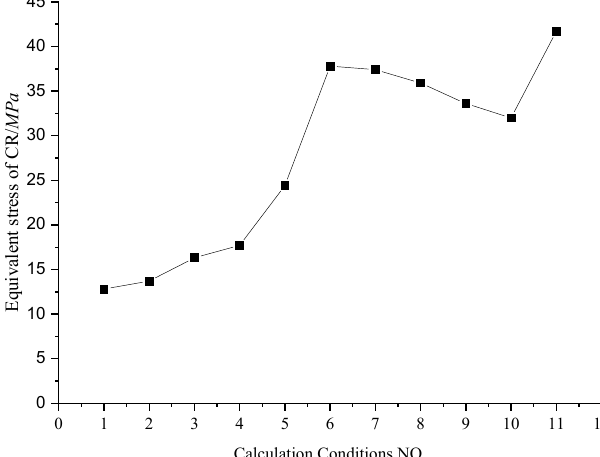
Calculation Conditions NO. Figure 26. Maximum equivalent stress curve of CR. Figure 26. Maximum equivalent stress curve of CR. Figure 26. Maximum equivalent stress curve of CR. The traction cable forces during each traction step are shown in Table 13, and the variation curve of cable forces during traction lifting is shown in Figure 27. In the process of traction lifting, the traction cable forces at 45° are always greater than those at the long and short axes. The maximum traction cable force is 1006.9 kN, which appears in the trac- tion cable at 45° when the traction lifting is completed (C11). Table 13. Traction cable force in process of traction and lifting. Table 13. Traction cable force in process of traction and lifting. Table 13. Traction cable force in process of traction and